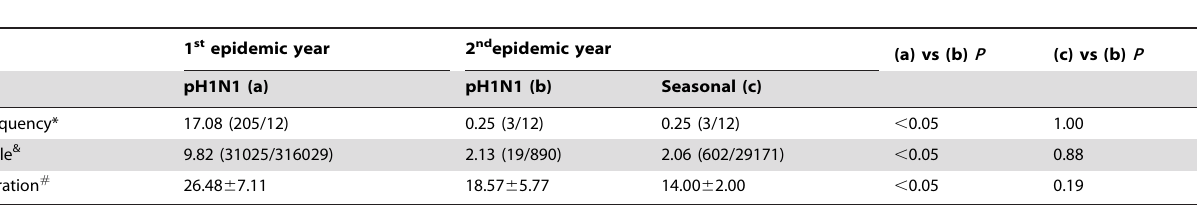
Table 1. The frequency, scale and duration of outbreaks of influenza in the first and second epidemic year.